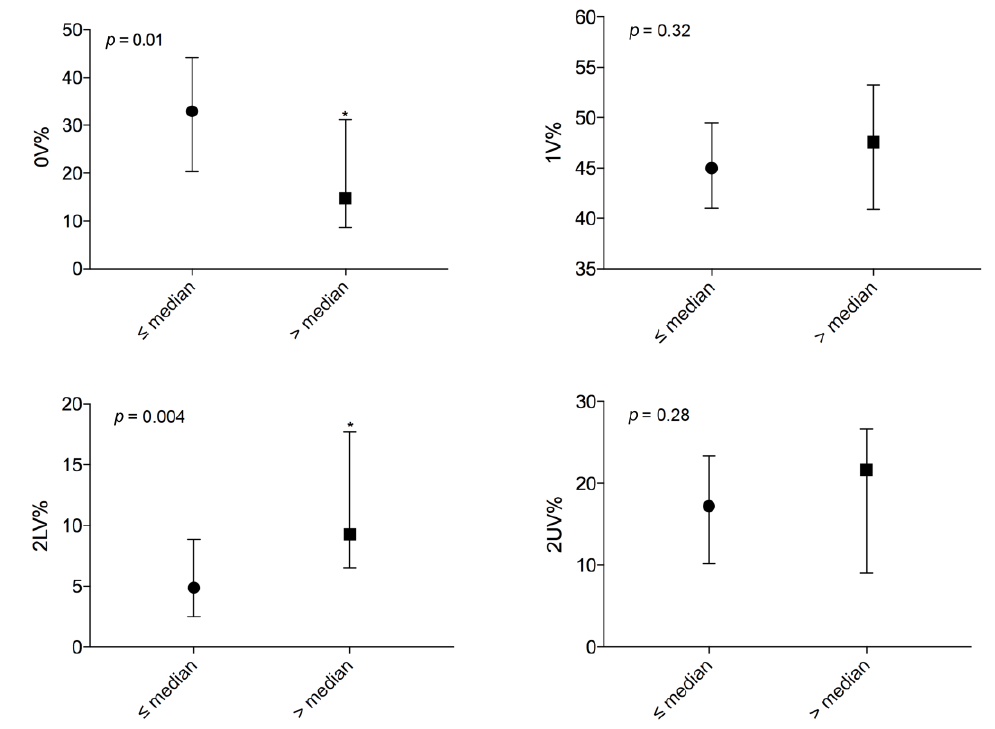
Figure 2. Comparison of autonomic parameters evaluated by symbolic analysis between patients on the lung transplant list with a LAS lower than or equal to the median ( n = 25) and patients on the transplant list with a LAS above the median ( n = 24); *, statistically significant.